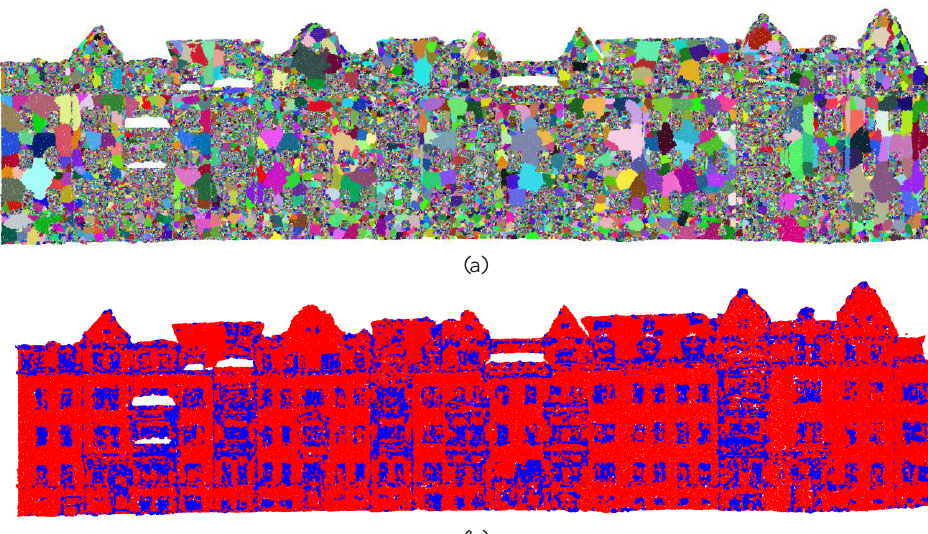
Figure 2. Multiscale supervoxel generation. (a) Multiscale supervoxels (b) Multiscale planar classification results. Red points belong to planar regions while blue points refer to non-planar